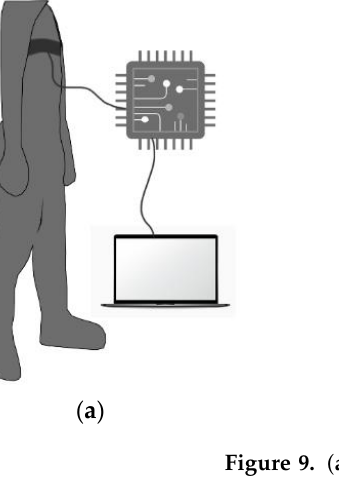
Figure 8. ( a ) Process of measuring ECG signal in swinging state. ( b ) ECG signal of woven fabric